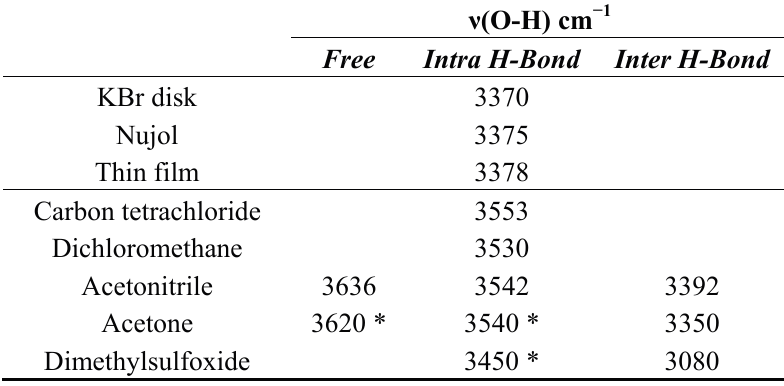
Table 1. Solid-state and solution O-H stretching of